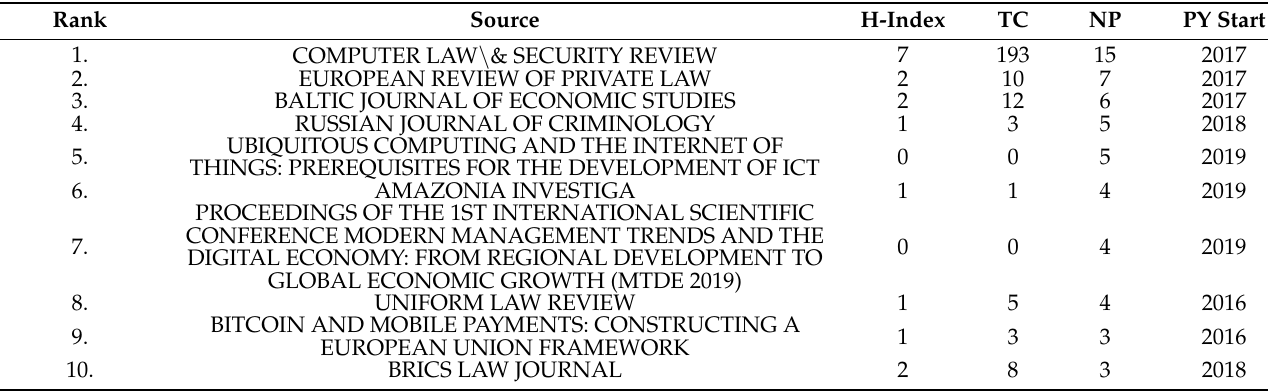
Table 5. Top 10 sources’ local impact (H-Index) during 2015–2019. TC (Total Citations), NP (Number of Publications), and PY (Publication Year